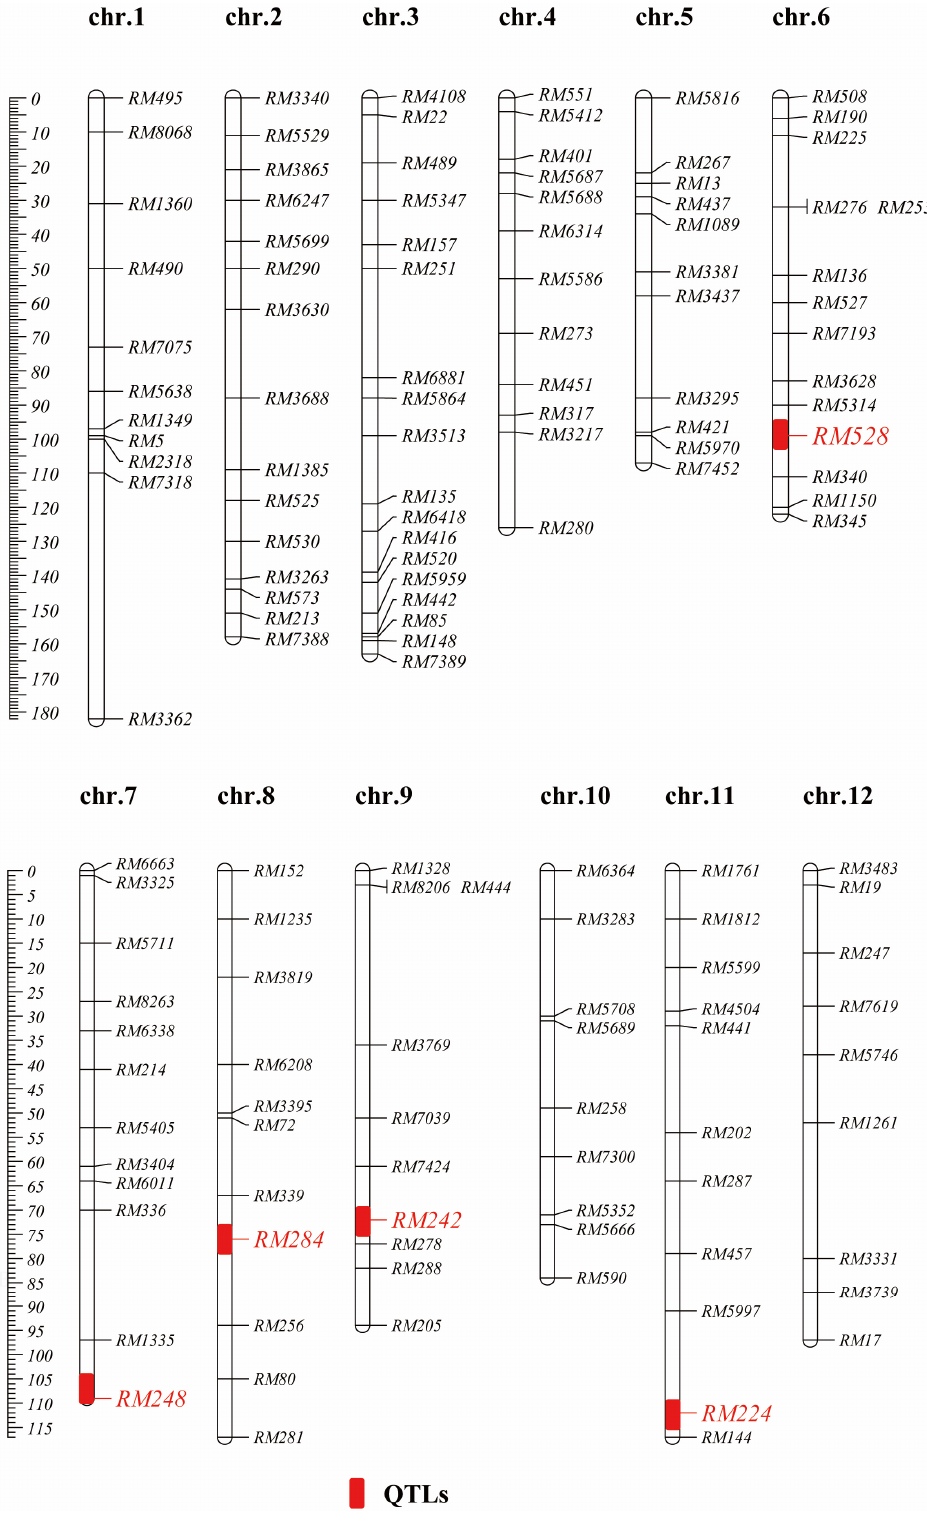
Figure 1. Genetic location of 143 polymorphic simple-sequence-repeat markers and distribution of QTLs for HT traits using simple-sequence-repeat. Molecular markers are shown to the right of chromosomes, and genetic locations (cM) of each marker shown to the left of chromosomes. Red rectangles indicate the QTLs for HT.